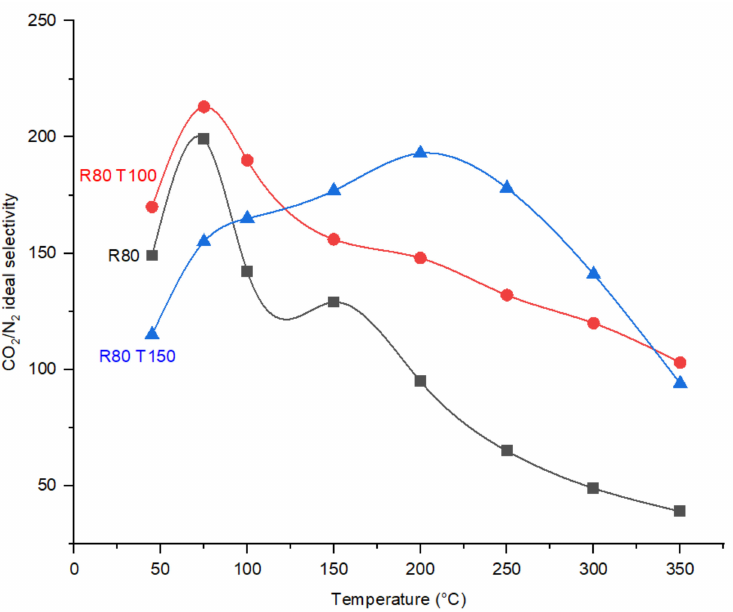
Figure 12. Effect of post treatment with oxygen on the CO 2 /N 2 ideal perm-selectivities of CMSMs (Carbon Molecular Sieve Membranes) as a function of temperature.